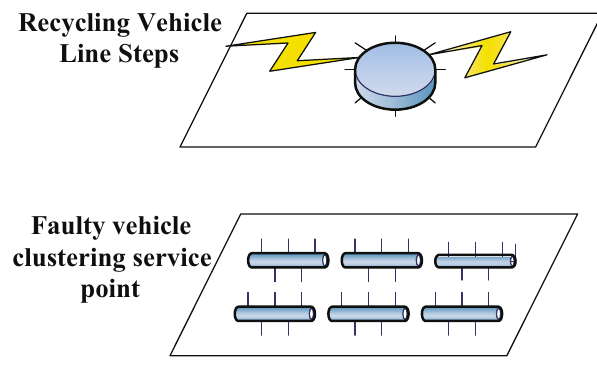
Figure 2: Shared bicycle breakdown vehicle recovery network.